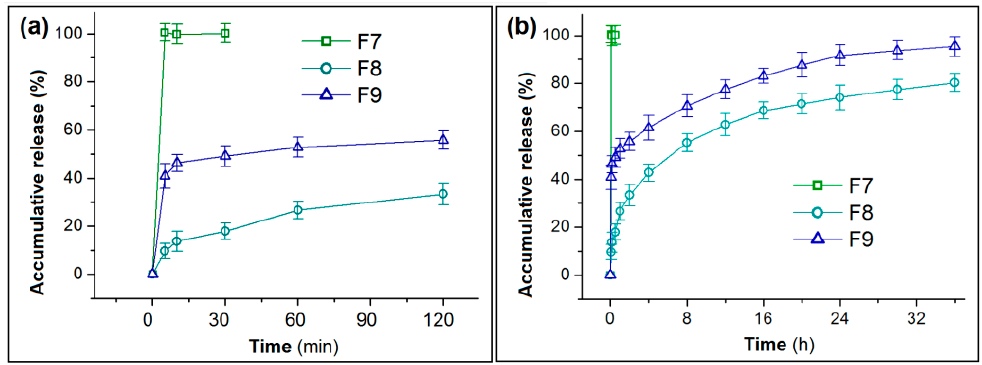
Figure 8. In vitro release profiles of IBU: ( a ) data of the first 2 h; ( b ) data of the full time period of 36